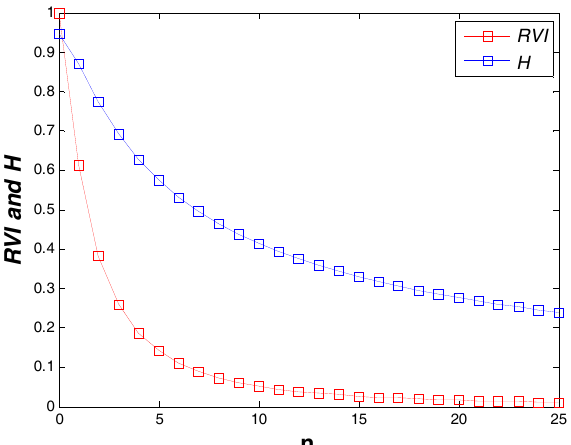
Figure 3. Dependence of RVI and H on the value of power variable n reproduced from [22,23]